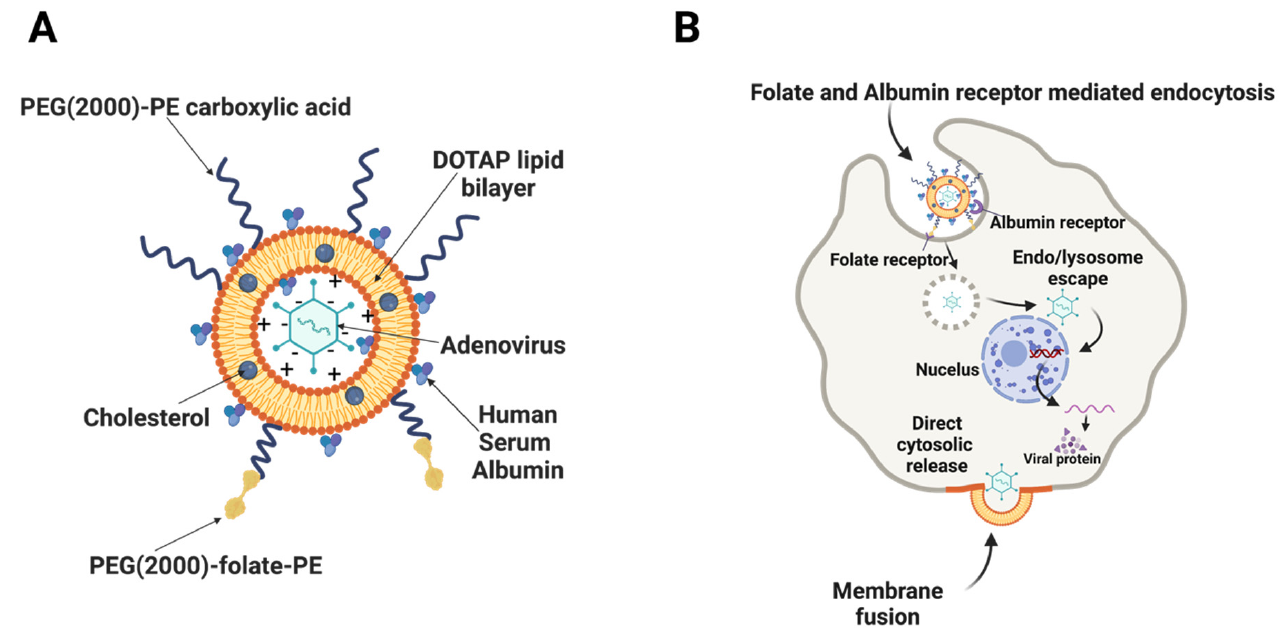
Figure 1. Structure of Ad liposome and its mechanism of action in CAR deficient cancer cells: ( A ) Uni-lamellar or multi-lamellar cationic liposome containing negatively charged Ad. ( B ) Ad liposomes contains folate-conjugated lipid that enhances cellular uptake into folate receptor positive cells by folate receptor-mediated endocytosis. Folate receptors are commonly expressed on numerous types of cancer cells [36–38] . Ad liposomes also contains Human Serum Albumin (HSA) and that enhances cellular uptake, possibly via albumin receptor-mediated endocytosis through receptors such as the 60-kDa glycoprotein (gp60) receptor, and Secreted Protein Acidic and Rich in Cysteine (SPARC) [39] .